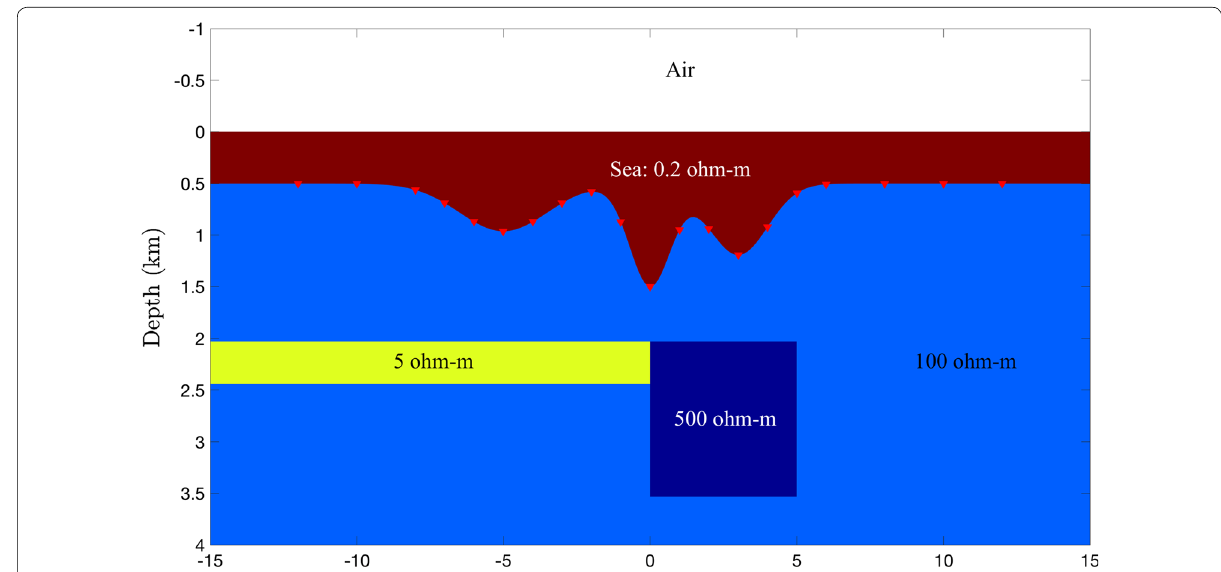
Fig. 11 Bathymetric model with mixing of Gaussian distribution functions. The sites marked as red triangles lie on the sea–earth